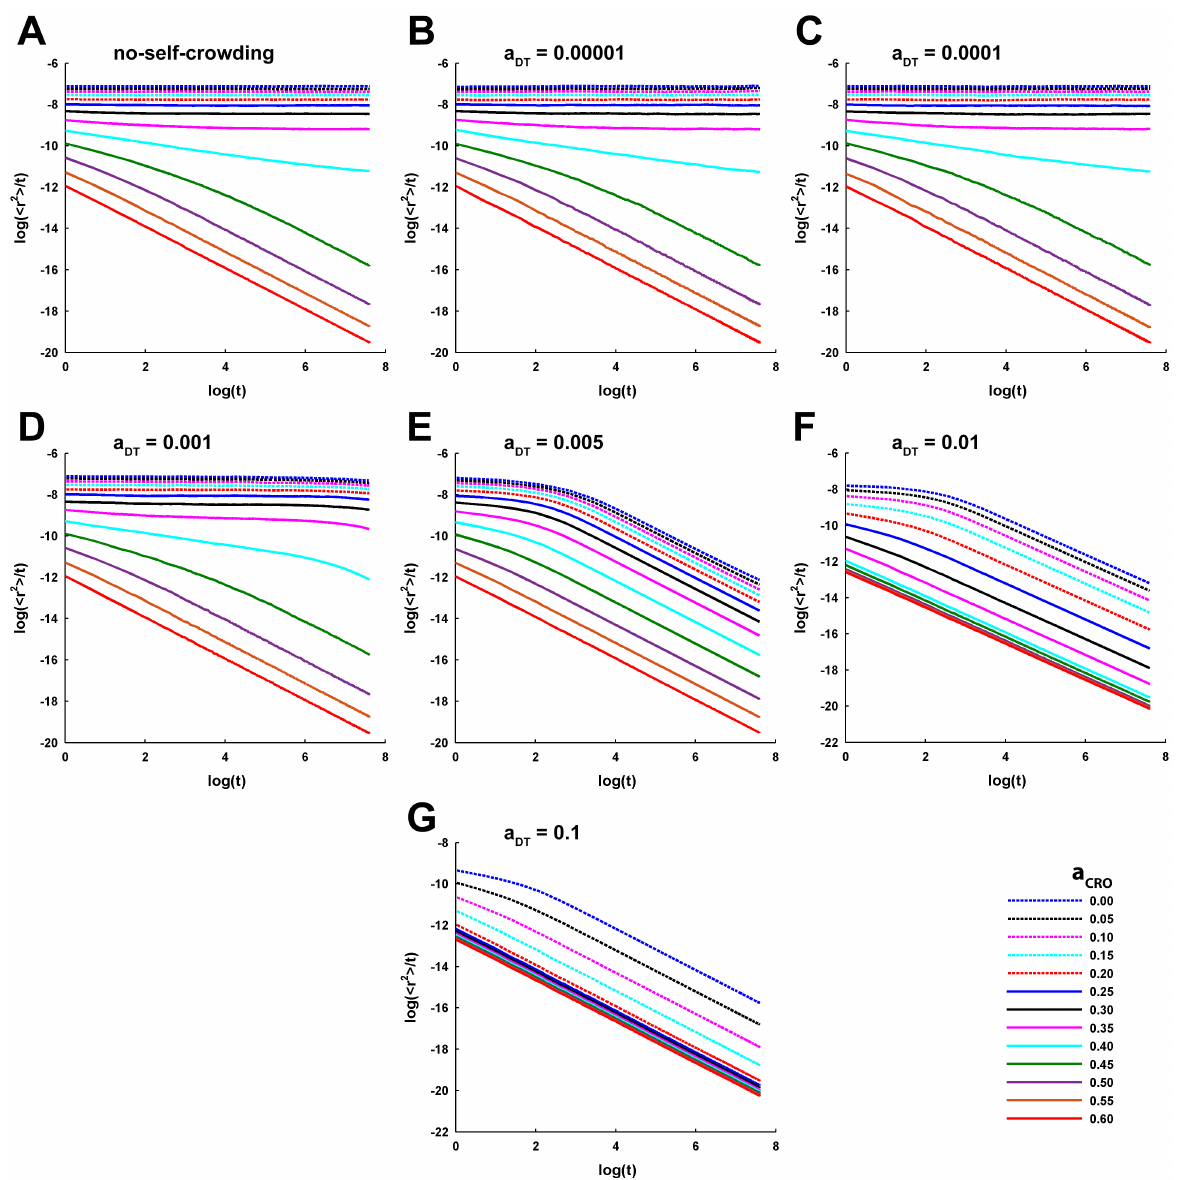
Fig 3. Log-log profiles of the ensemble-averaged MSD under different self-crowding conditions and CRO densities. The profile of variation in natural logarithm of the ratio of ensemble-averaged MSD to time,log ( h r 2 i / t ), with respect to the natural logarithm of time, log ( t ), is referred here as the log-log profile for simplicity. (A-G) Each plot demonstrates the log-log profiles of MSD across the increasing CRO density for a given condition of self-crowding. Perfectly normal diffusion is characterized by a flat or horizontal log-log profile across the entire duration of MSD measurement. However, profiles exhibiting sharp linear decrease at longer time characterize strongly anomalous sub-diffusion or confined diffusion and indicate the original dependence of MSD on time raised to a fractional power (power-law relation). There are profiles too which show transition from anomalous to normal diffusion. Evidently, tracer diffusion is observed to be confined and strongly anomalous at higher densities of CROs and